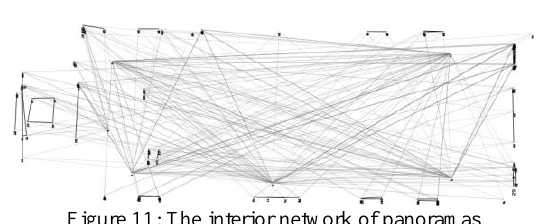
Figure 11: The interior network of panoramas Having those oriented panoramas gives the possibility to plot 3d points (Fangi and Nardinocchi, 2013) and even to create wireframe or polygonal 3d models (Fangi and Wahbeh, 2013). In the Bel temple case it was used as a basis for referencing the produced point cloud to a defined coordinates system. The point clouds were referenced adding the 3d points as markers giving them their specific coordinates to translate and scale the entire block to the real scale and the correct orientation.